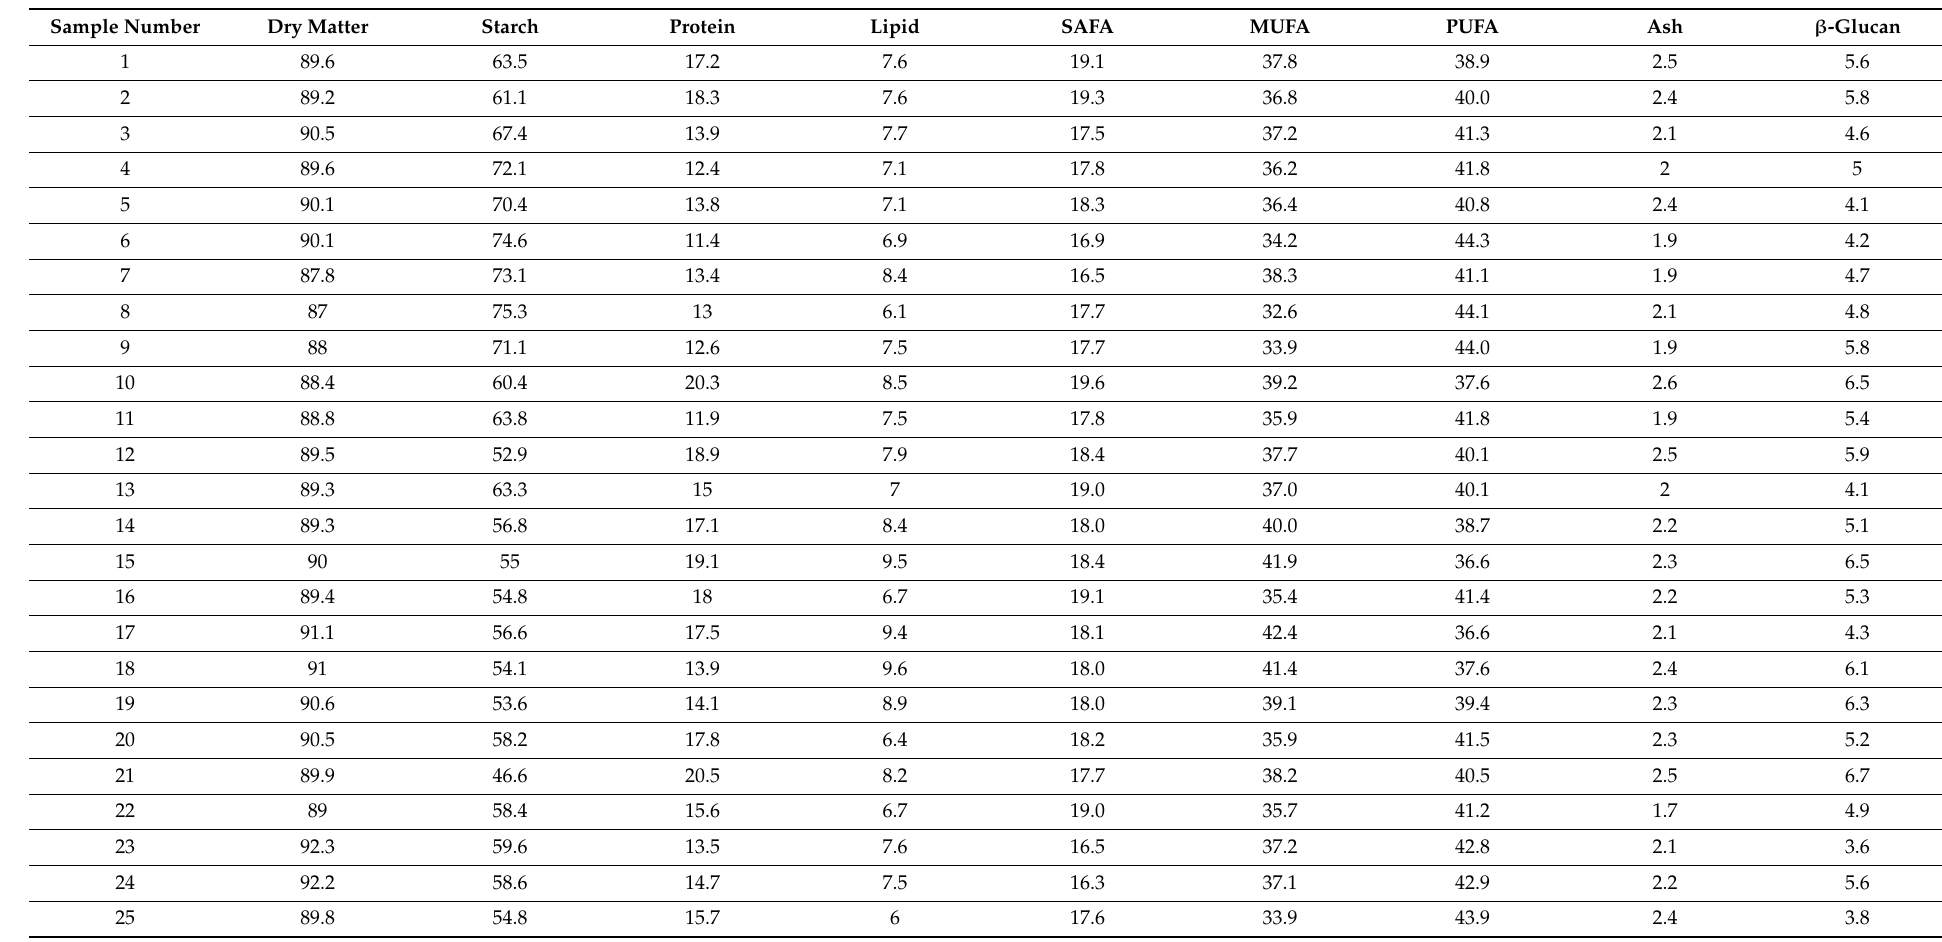
Table A3. Chemical composition of 30 non-heated oat flours. All of the results are on a dry matter basis (%). SAFA, MUFA and PUFA are presented as shares of total fatty acids (%). Sample